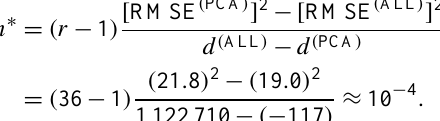
Table 4. Nowcasting errors ( RMSE ) on the testing dataset.